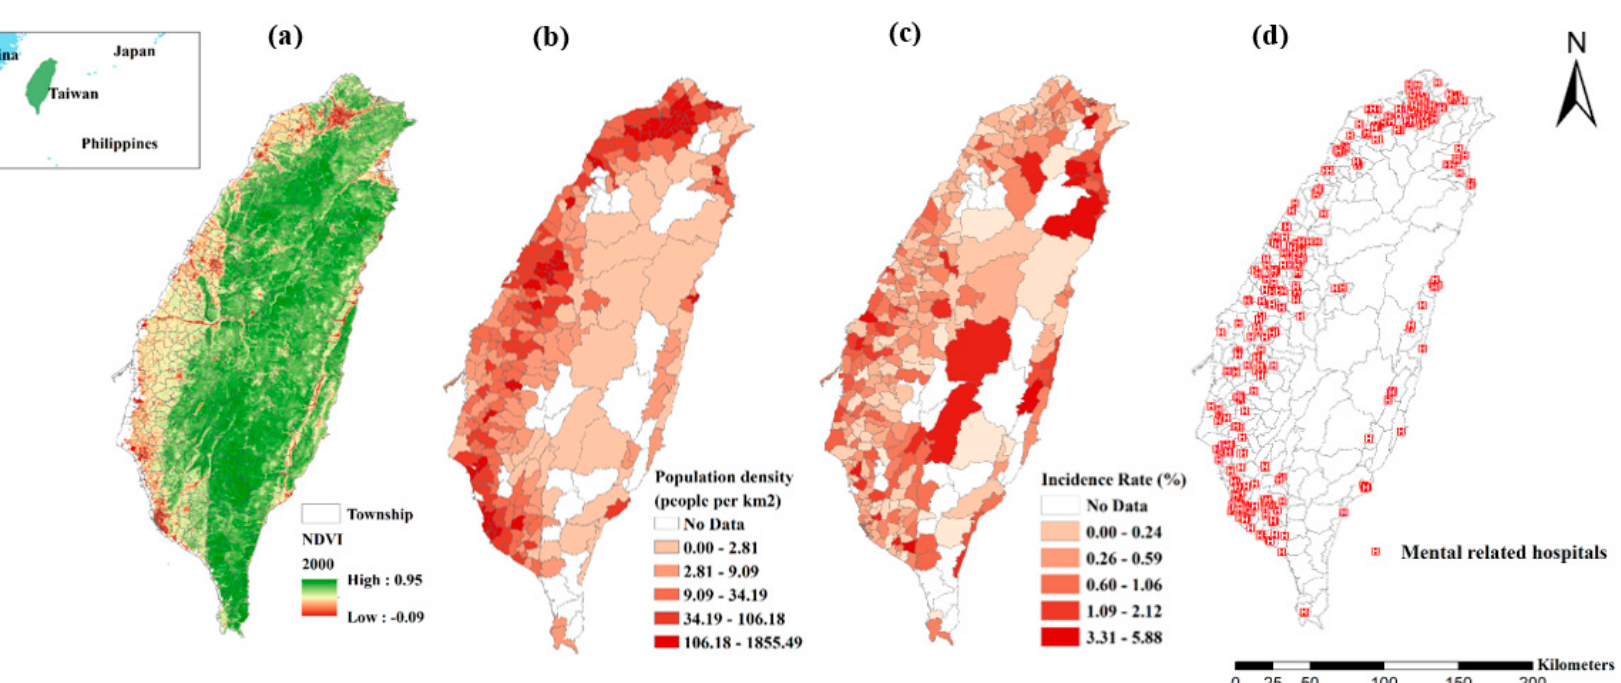
Figure 1. Databases displayed in the location of Taiwan. ( a ) The spatial variability of greenness within the whole island based on the MODIS NDVI (Normalized Difference Vegetation Index) image of 2000. ( b ) The township scale of population density ( c ) The township scale of incidence rate from 2000 to 2010. ( d ) The location of mental related hospitals in Taiwan.